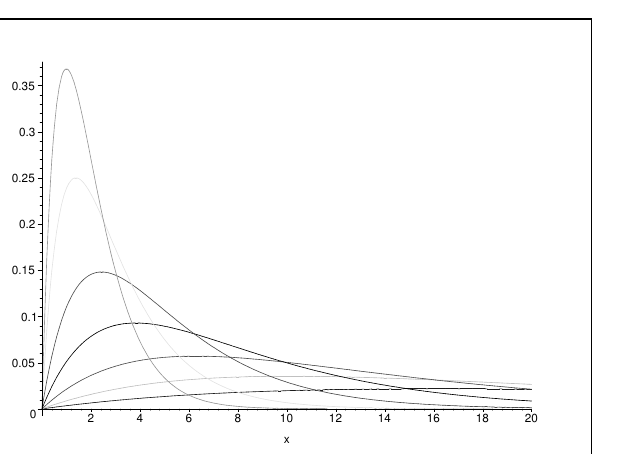
Figure 1 – Graphs of f